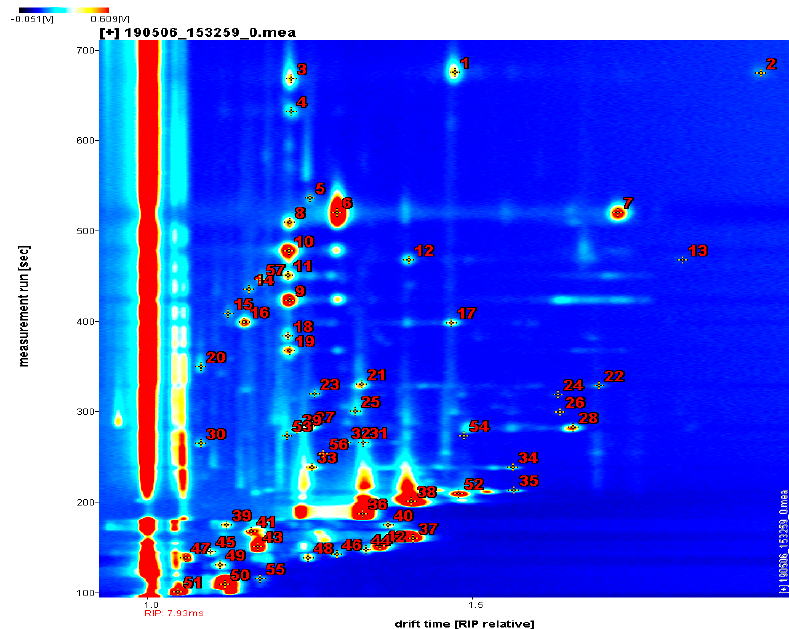
Figure 4. Ion migration spectra of volatile compounds represented by GC-IMS spectra in dry-cured beef. The numbers (1–57) are the identified volatile components.